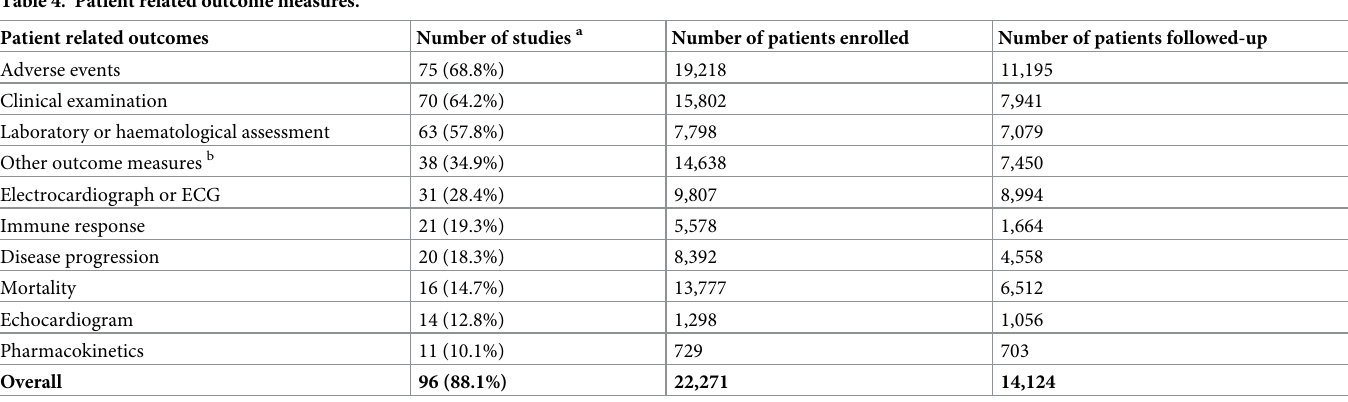
Table 4. Patient related outcome